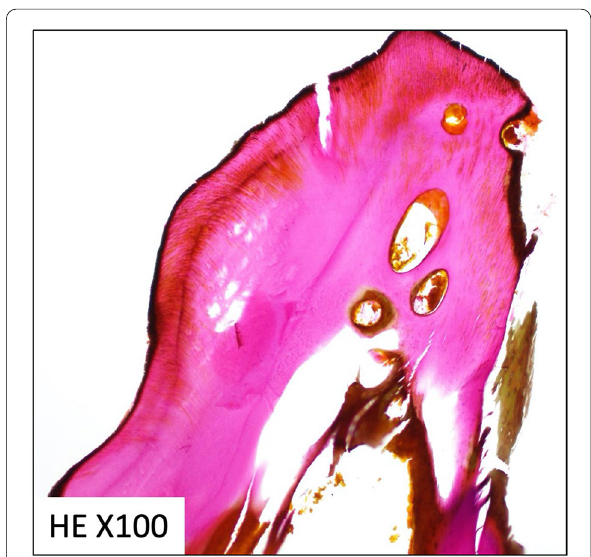
Fig. 4 Histological hematoxylin–eosin (HE) staining of the needle-shaped foreign body. The bone matrix that was constructed with collagen fibers was dyed red with